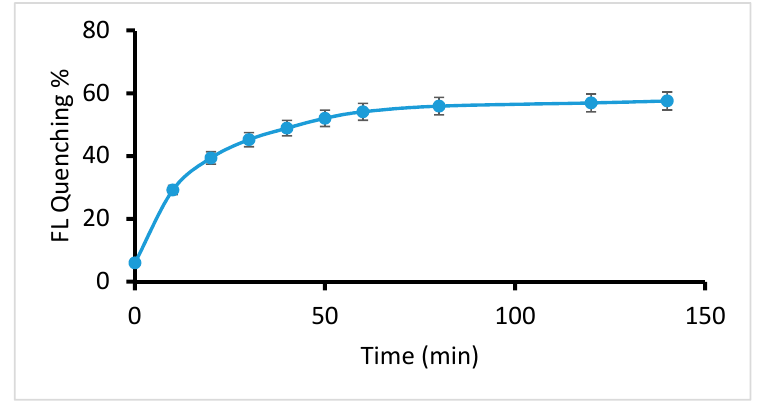
Figure 5. Effect of reaction time on QDs fluorescence quenching by verapamil HCl.